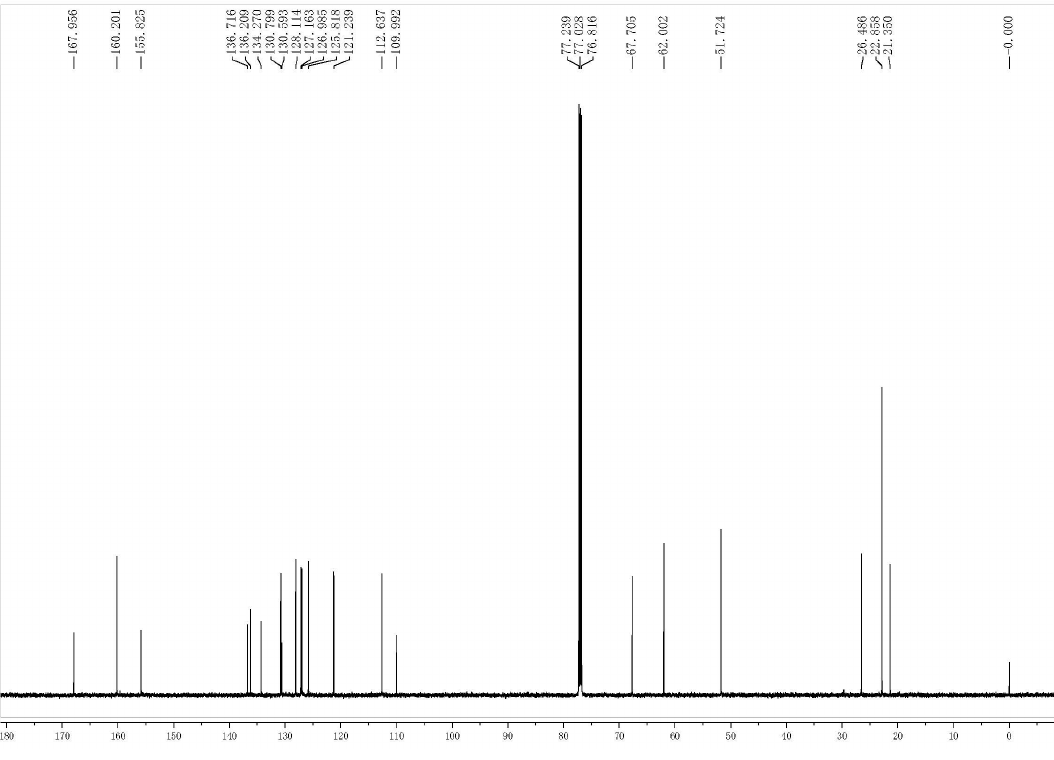
Figure 4. Representative 13 C-NMR spectrum of compound II-1 .